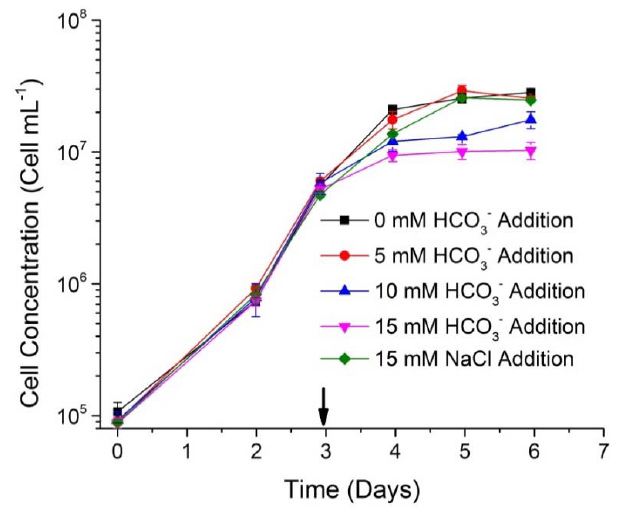
Figure 3. Scenedesmus sp. WC-1 mean growth and standard deviation of cultures which were sparged with 5% CO ( v / v ) in air and switched to ambient air, at which time they 2 were amended with 0, 5, 10, and 15 mM sodium bicarbonate, along with 15 mM sodium chloride as a control amendment. The arrow indicates time of the gas sparge change and salt amendments. Growth was maintained in unbuffered Bold’s basal medium illuminated with a 14:10 L/D cycle ( n = 3).